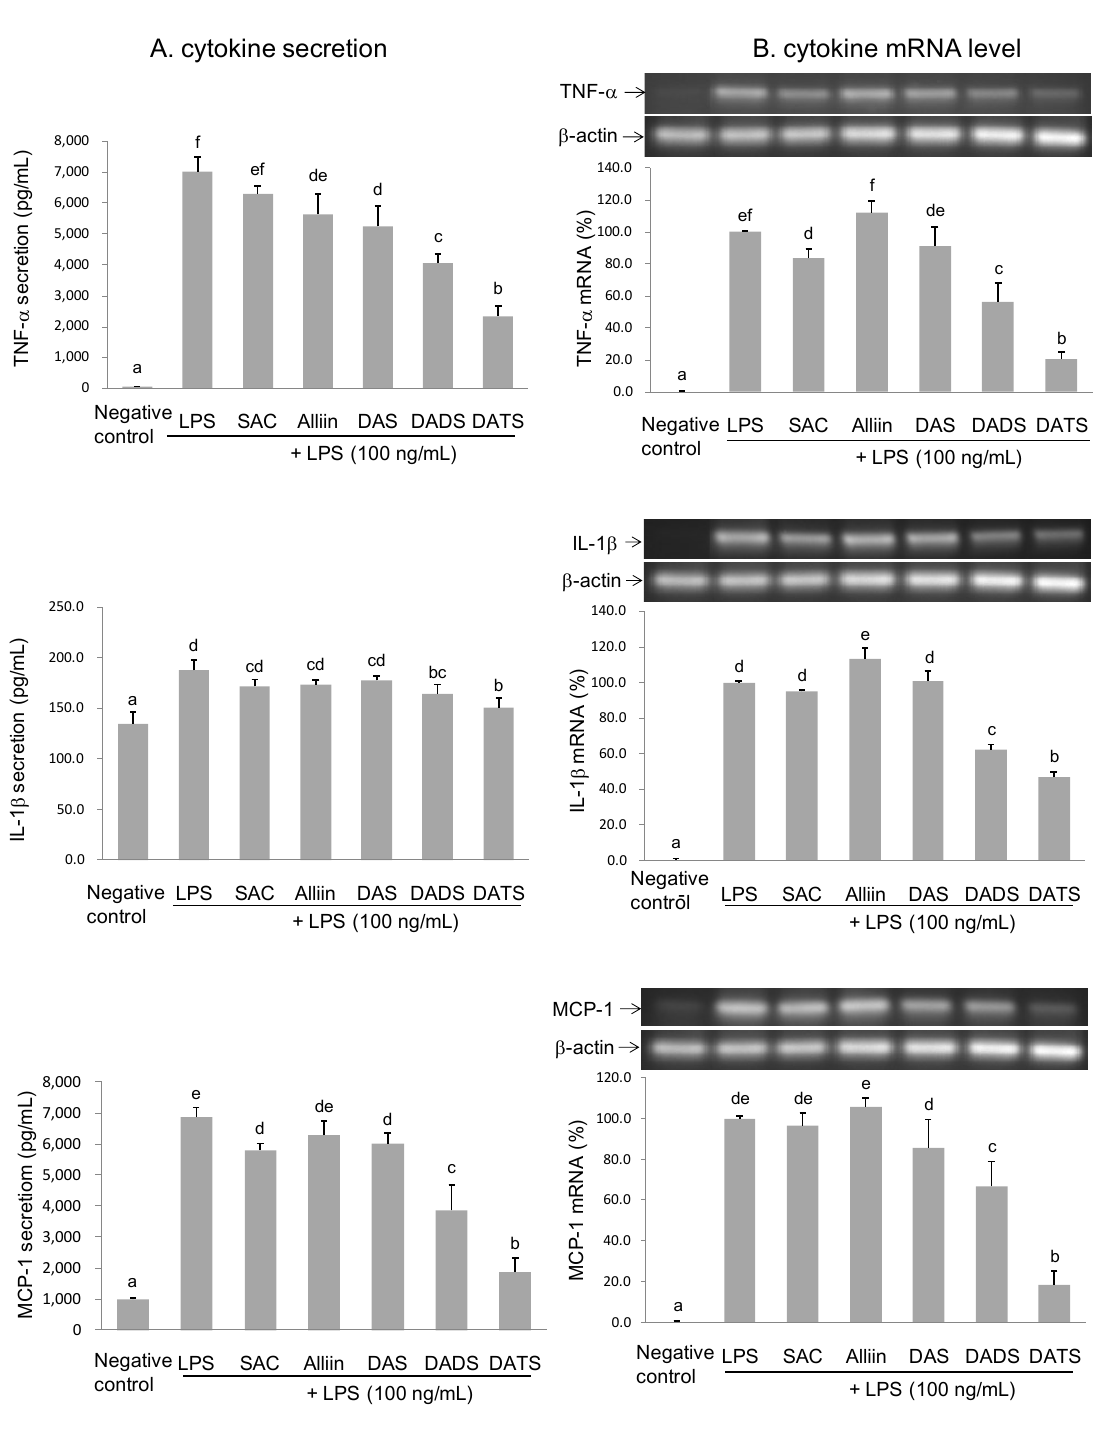
Figure 5. Effects of the selected OSCs on TNF-α, IL-1β and MCP-1 secretion ( A ) and mRNA level ( B ) in LPS-activated BV2 microglia. The treatment concentration is 1000 µM for SAC, alliin and DAS; 400 µM for DADS; and 200 µM for DATS. The values are expressed as means ± SD of triplicate tests. Means not sharing a common letter are significantly different ( p < 0.05) when analyzed by ANOVA and Duncan’s multiple range